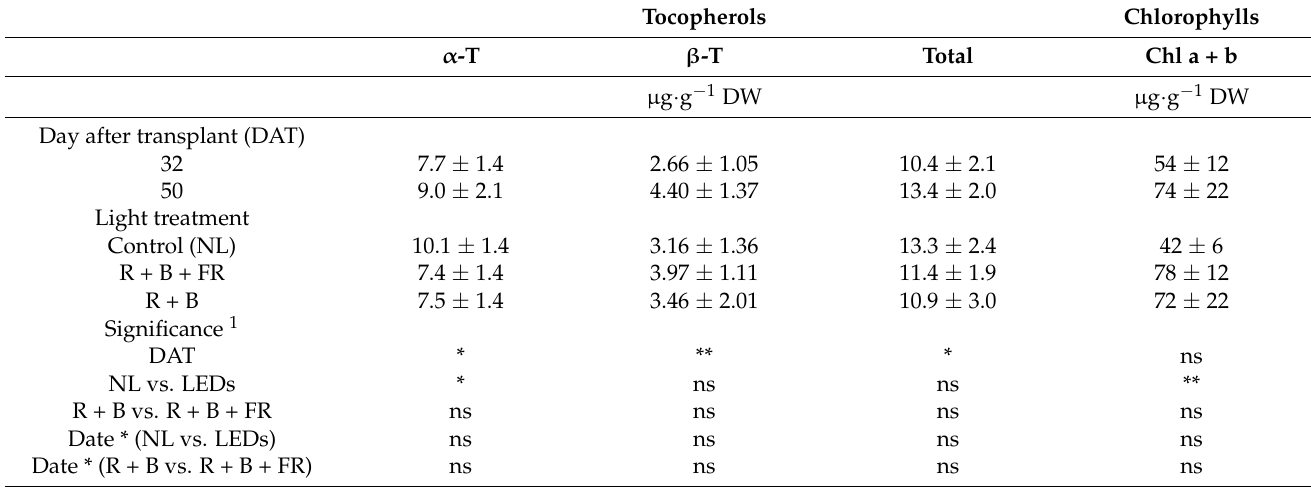
Table 2. Tocopherol and chlorophyll content of the fruits of a landrace of Cucumis melo L. (“Carosello leccese”) sampled 32 or 50 days after transplant (DAT) from plants subjected to different light treatments. Values are average ± SD of three